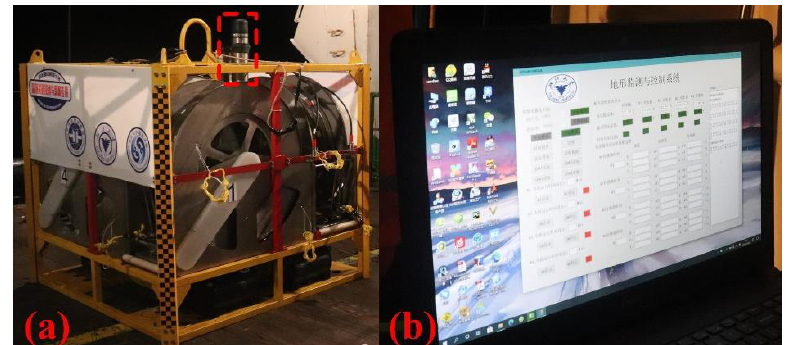
Figure 6. ( a ) Acoustic communication; ( b ) Software on host computer (normal status).